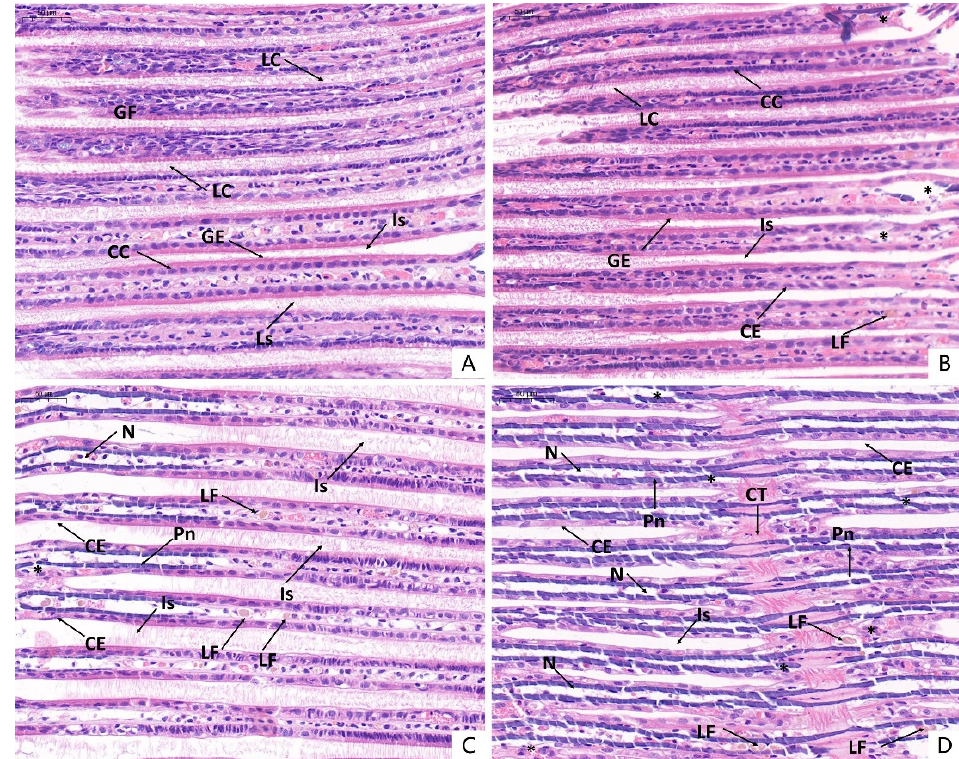
Figure 5. Time-course histopathological changes in gills of H. cumingii under ammonia stress. ( A ) Control gills; ( B–D ) Gills at hours 24, 48, and 96, respectively. LC: lateral cilia; GF: gill filament; GE: gill epithelium; CC: columnar cell; Is, inter- lamellar space; CT: connective tissue; LF: lipofuscin; Pn: pyknosis of nuclear; N: necrosis; CE: cilia exfoliation; asterisks: loss of structural integrity. Scale bar = 50 μ m (×200).